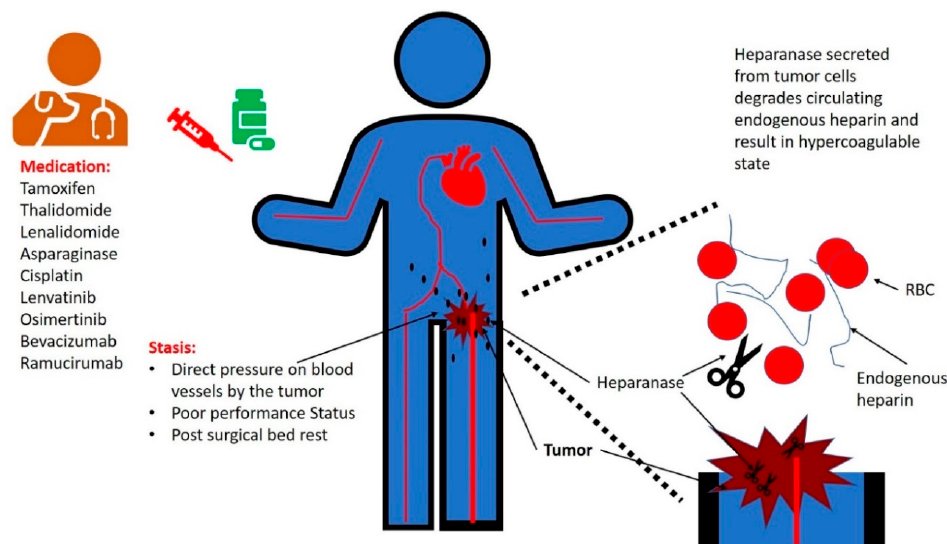
Figure 1. Cancer-associated thrombosis can result from: (1) stasis, i.e., direct pressure on blood vessels by the tumor mass, poor performance status, and bed rest following surgical procedures; (2) iatrogenic, due to treatment with antineoplastic medications; and (3) secretion of heparanase from malignant tumors that results in degradation of endogenous heparin.